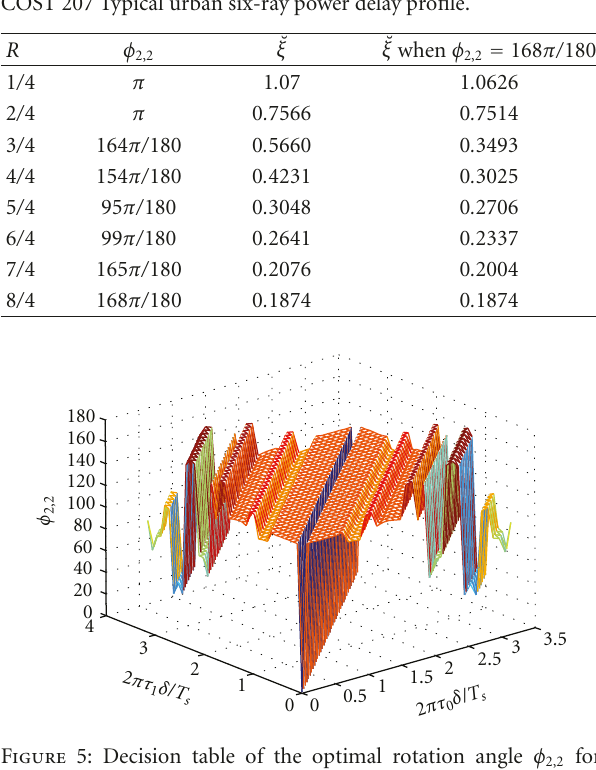
Figure 5: Decision table of the optimal rotation angle φ 2,2 for multirate MRP in a MIMO-OFDM subsystem with P = 4, R = N Γ = 2, and BPSK constellation. t =